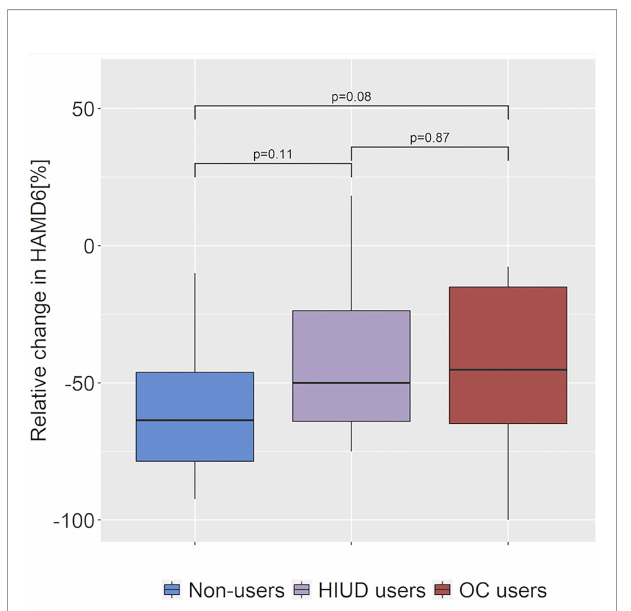
FIGURE 2 | Antidepressant drug treatment response at week eight across hormonal contraceptive user status. Difference in relative change in Hamilton Depression Rating Scale 6 items (HAMD6) from baseline between the HC non-users, the hormonal intrauterine device (HIUD) users and the oral contraceptive (OC) users. A larger negative change corresponds to a better improvement of depressive symptoms. P-values are computed with Mann- Whitney tests with no correction for multiple comparisons.